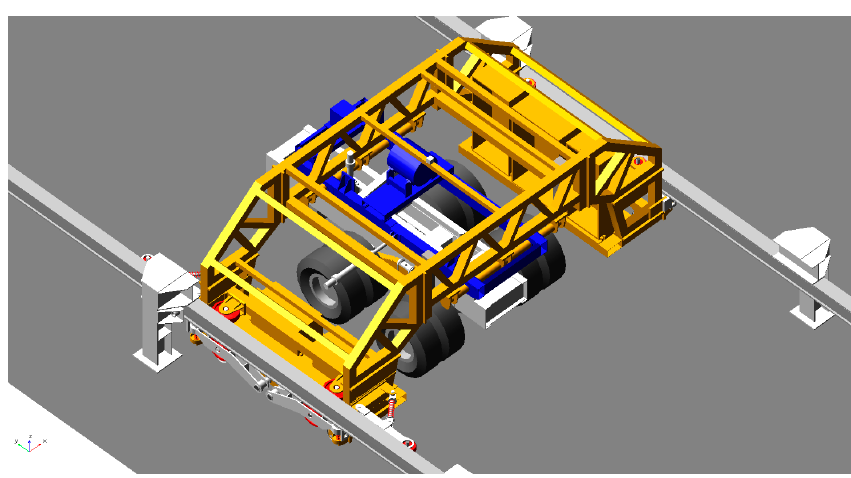
Figure 3. Virtual prototype model of NE-ALT.